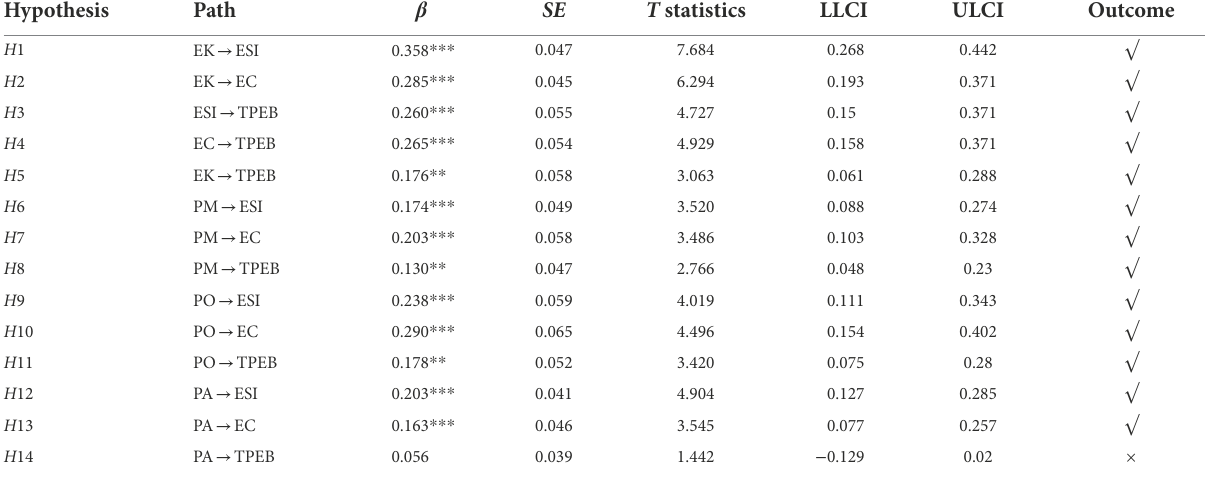
TABLE 6 Model hypothesis statistics (bootstrapping).